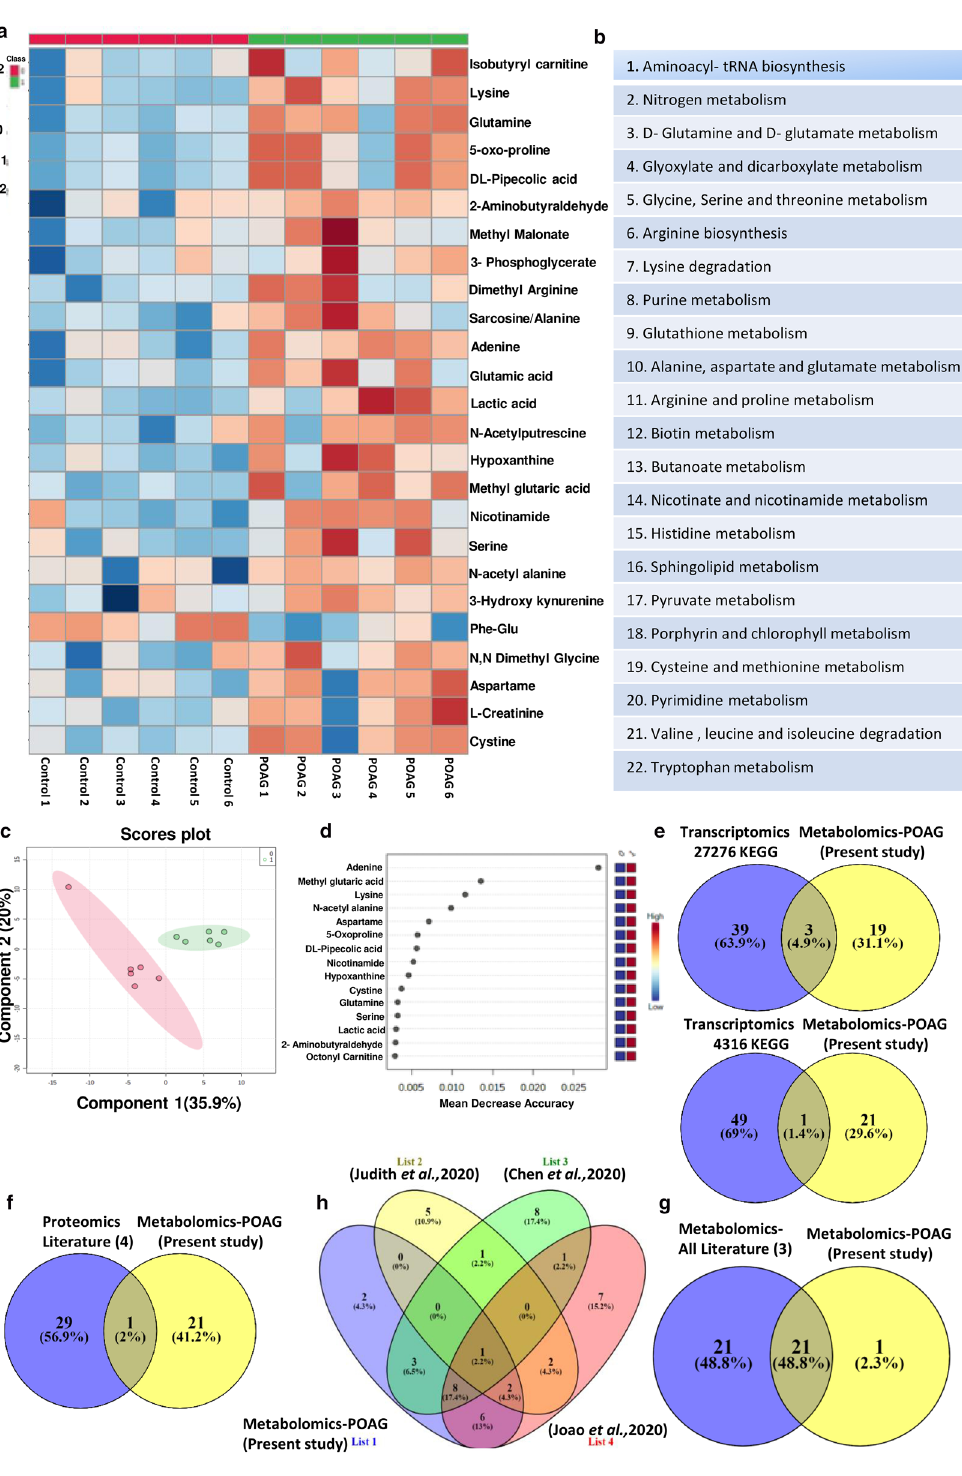
Figure 2. Showing results of targeted metabolomics analysis of aqueous humor in POAG compared to controls. ( a ) Heat map of metabolomic analysis of control and POAG patient cohort. ( b ) List of pathways to which significant differential metabolites belong to POAG are binned at an FDR of 0.25. ( c ) Unbiased PLS-DA clustered the samples into two different group is represented by a score plot ( d ) showing Random Forest analysis distinguishing POAG from controls ( e ) showing overlap of metabolic pathways with transcriptomic data set (GSE27276 and GSE4316) using KEGG ( f ) Comparative analysis of proteomic data (Literature) with metabolomic data (present study) showing one conserved pathway. ( g ) showing overlap of 21 pathways between metabolomics data (present study) and metabolomics (Literature) ( h ) Flower model Venn diagram showing overlapping pathways among metabolomics data from present study and those from Literature. ( a , c , d ) was generated using MetaboAnalyst 5.0 (Version-5.0; URL link: https:// www. metab oanal yst. ca/). ( e – h ) was created using VENNY 2.1 (Version-2.1; URL link: https:// bioin fogp. cnb. csic. es/ tools/